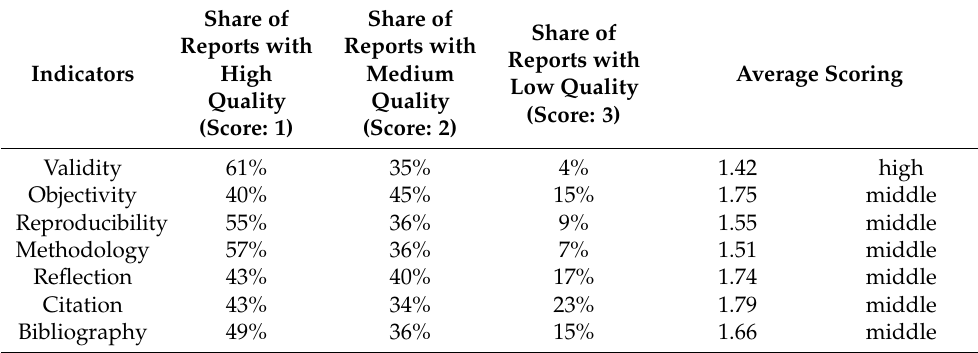
Table 2. This table shows the assigned scores of the 7 indicators in class A based on the qualitative assessment of 53 student